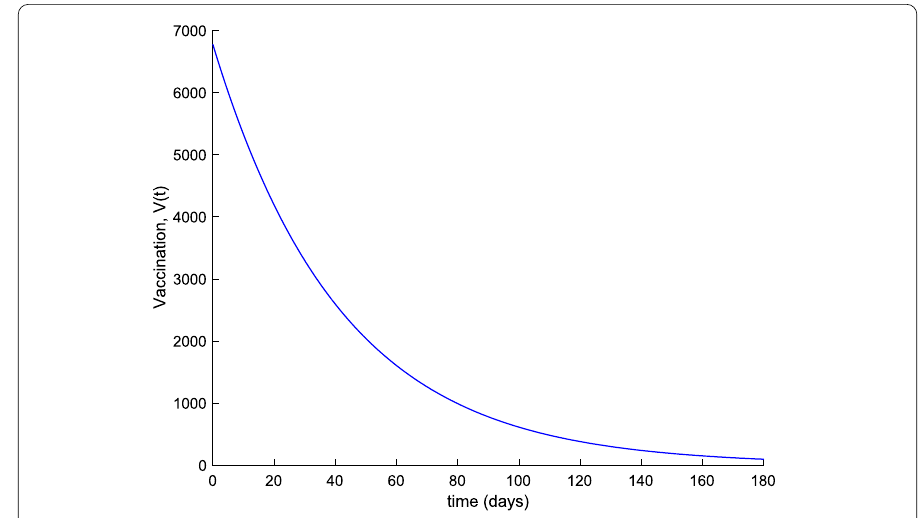
Figure 9 Vaccination action when k V = 0.001 and no treatment is applied